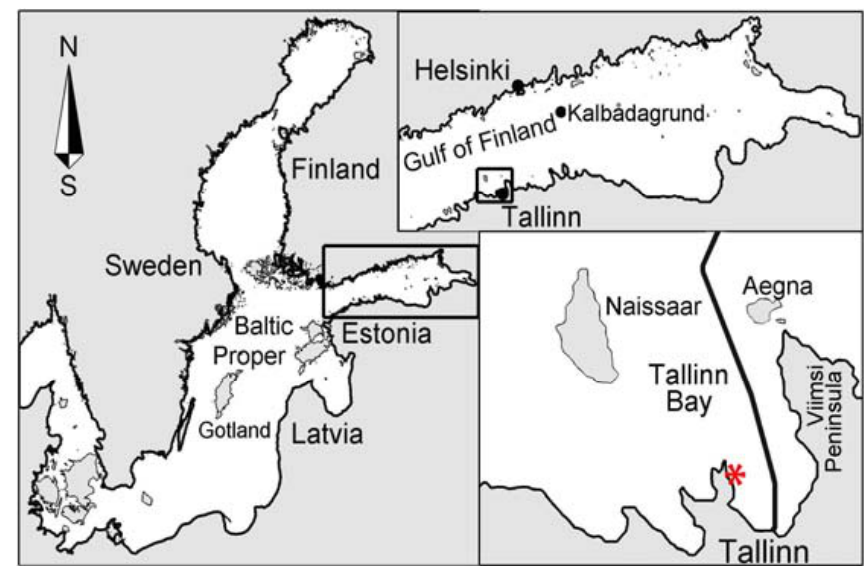
Fig. 1. Location scheme of the Baltic Sea and the study site.